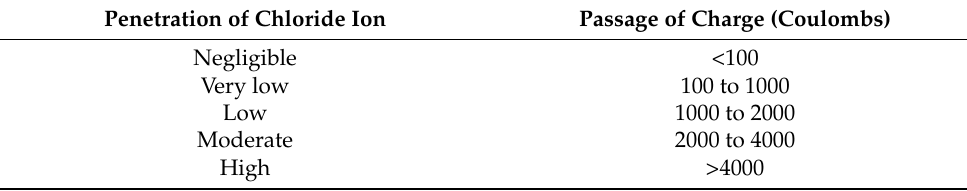
Table 1. Chloride ion penetrability depending on the extent of passing charge